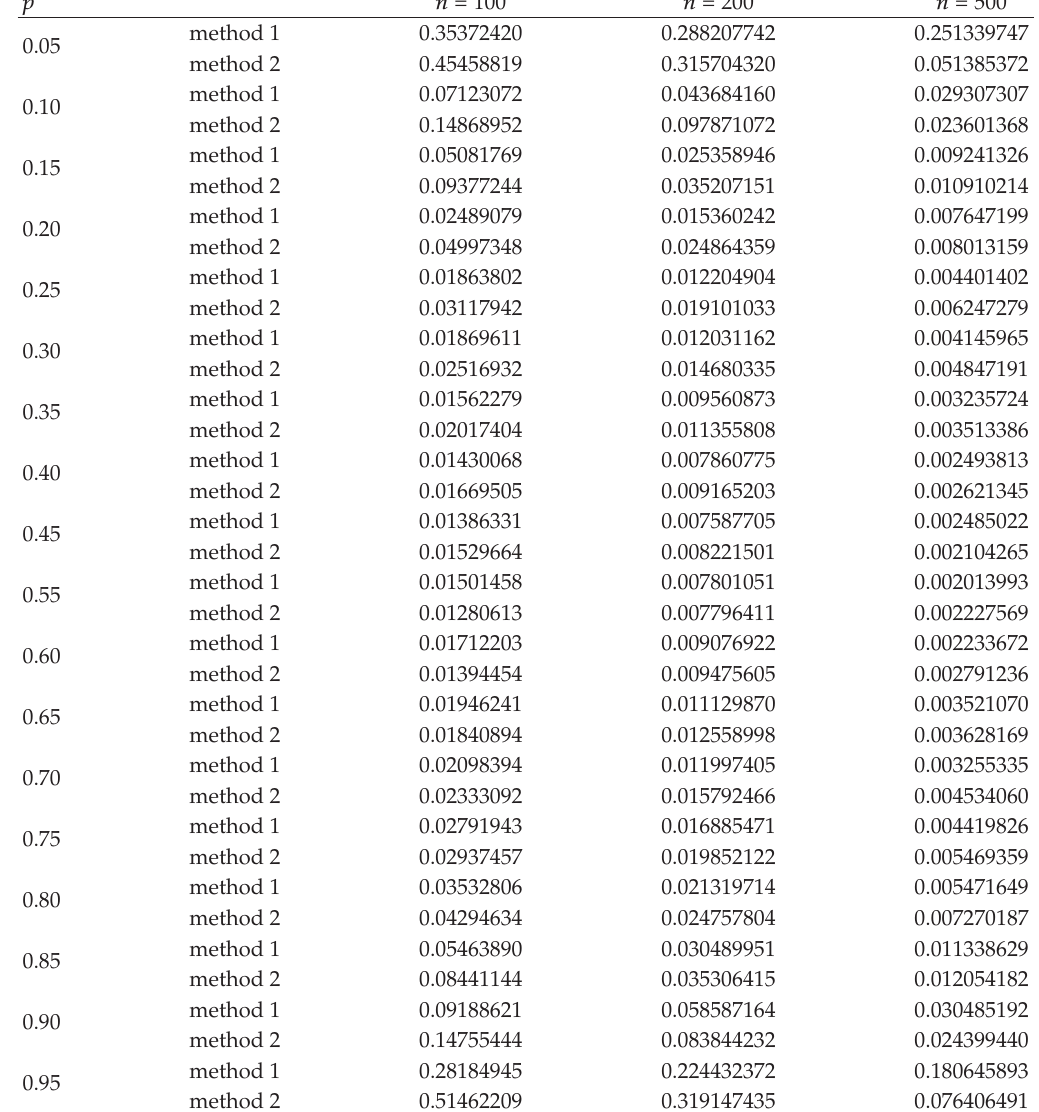
Table 4: Mean squared errors results for bandwidth selection methods for di ff erent sample sizes and for data from a double exponential distribution.